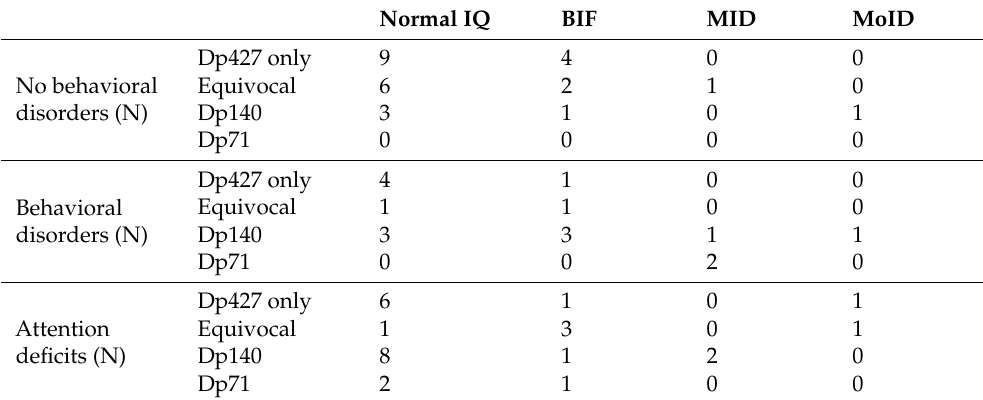
Table 1. Details of the brain dystrophin involvement in the different subgroups of intelligent quotients (IQ) levels, behavioral findings, and brain dystrophin